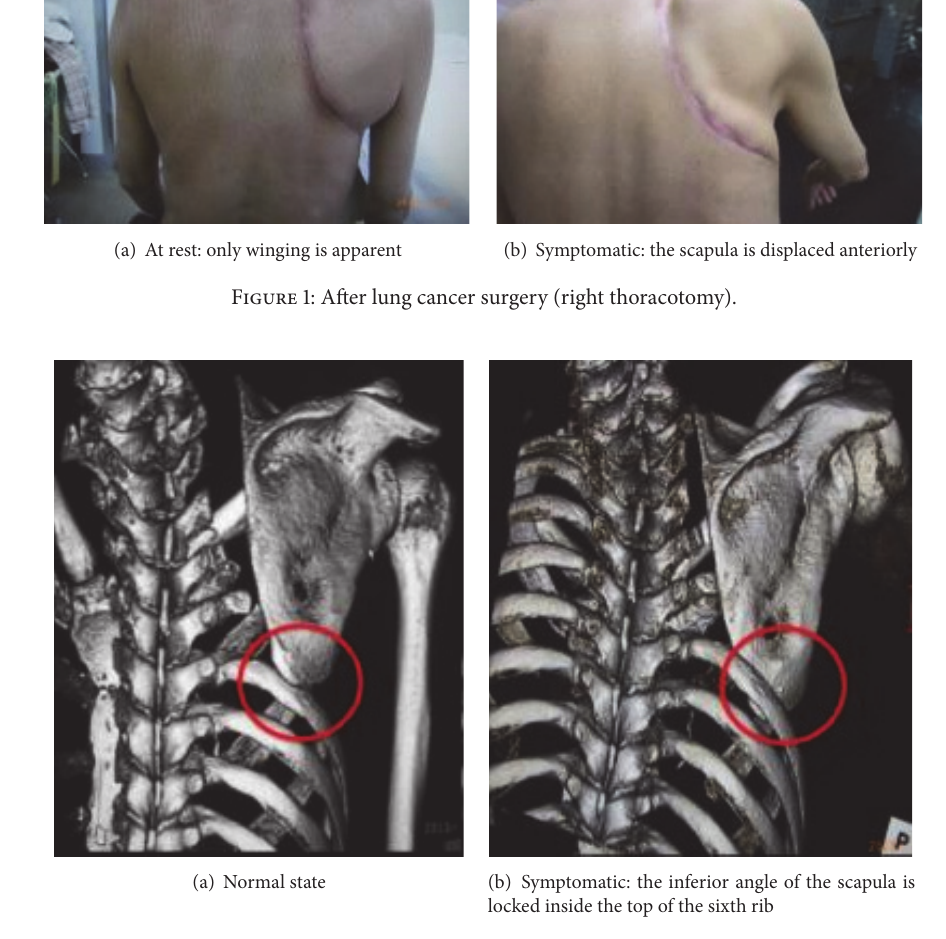
Figure 2: Preoperative